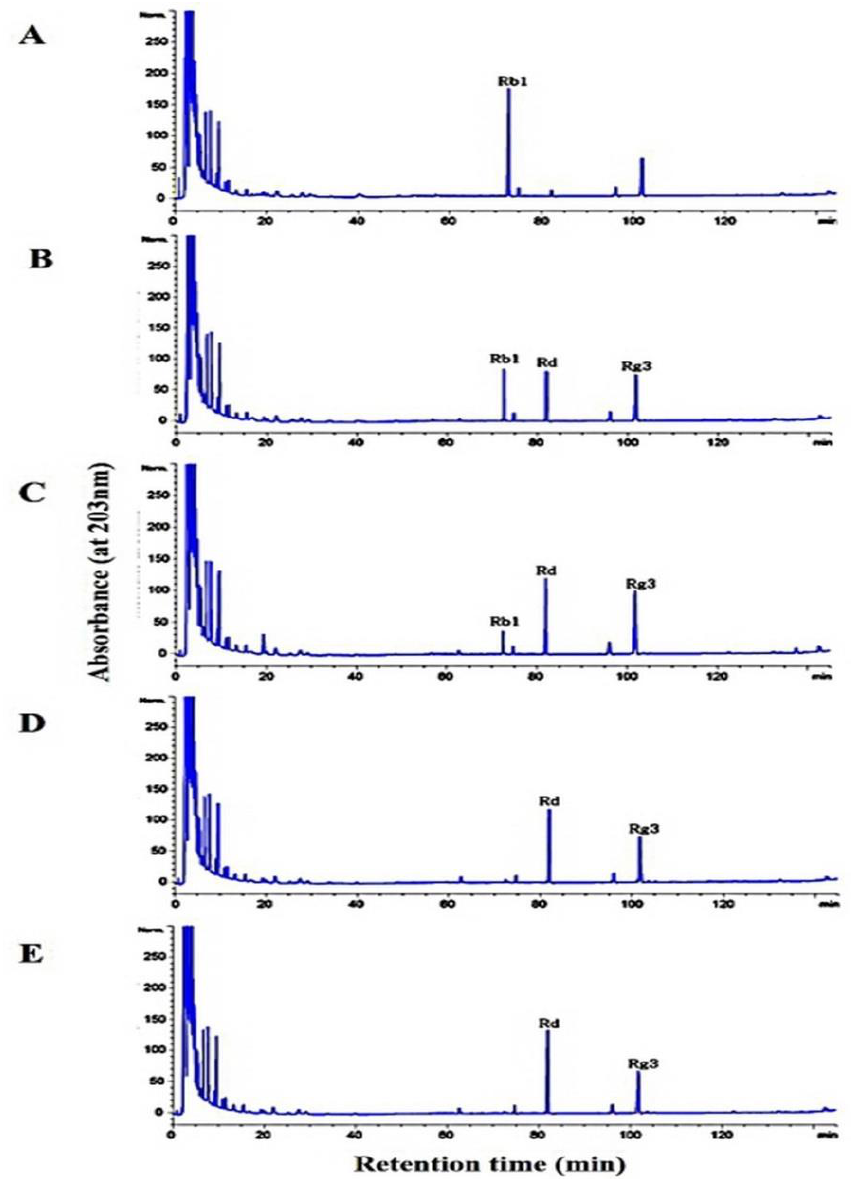
Figure 7. Conversion of ginsenoside Rb1 by crude enzyme from Lactobacillus buchneri URN103L: ( A ) 0 days; ( B ) 3 days; ( C ) 7 days; ( D ) 10 days; ( E ) 14 days.